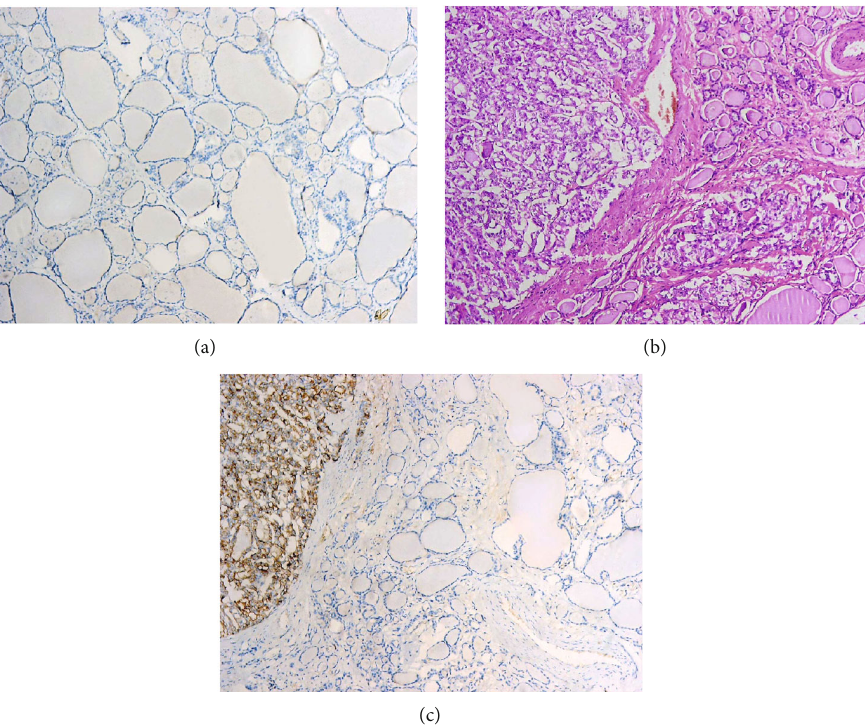
Figure 1: Normal thyroid tissue (control): showing low SLC34A2 IHC expression (IHCX100) (a), PTC with adjacent normal thyroid tissue: (H&EX100) (b), and PTC showing high SLC34A2 IHC expression in contrast with low SLC34A2 IHC expression in adjacent normal thyroid tissue (IHCX100)